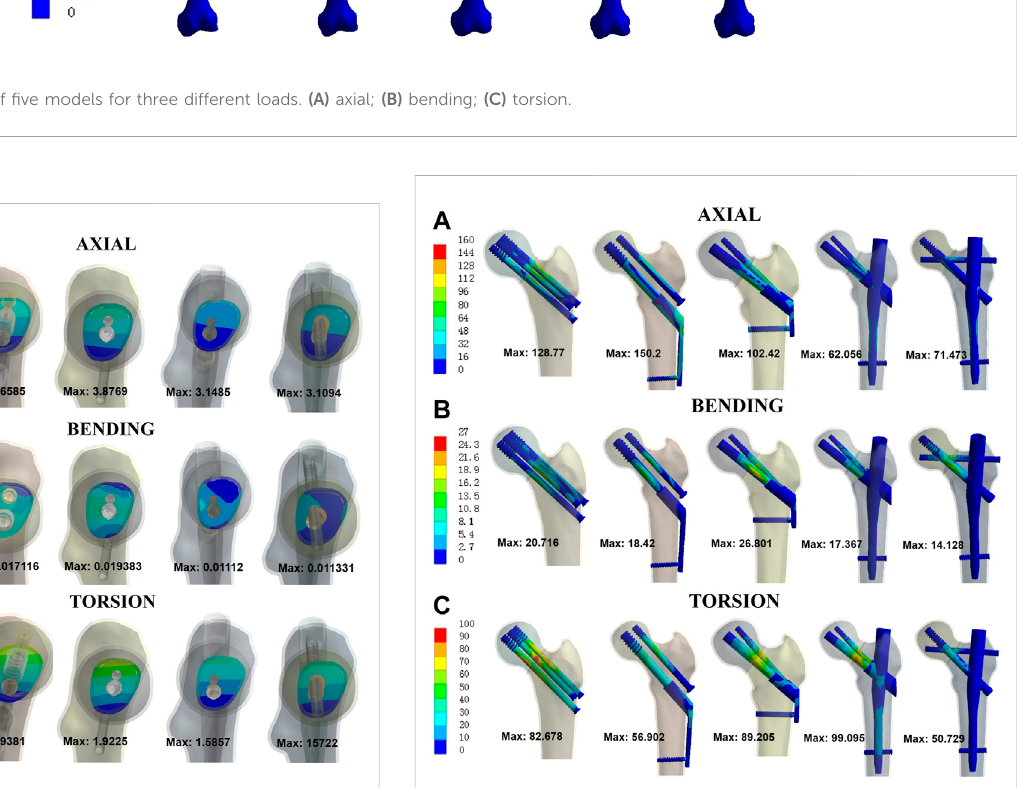
FIGURE 4 Maximal displacement of fracture surface for fi ve models under three different loads. (A) axial; (B) bending; (C) torsion.